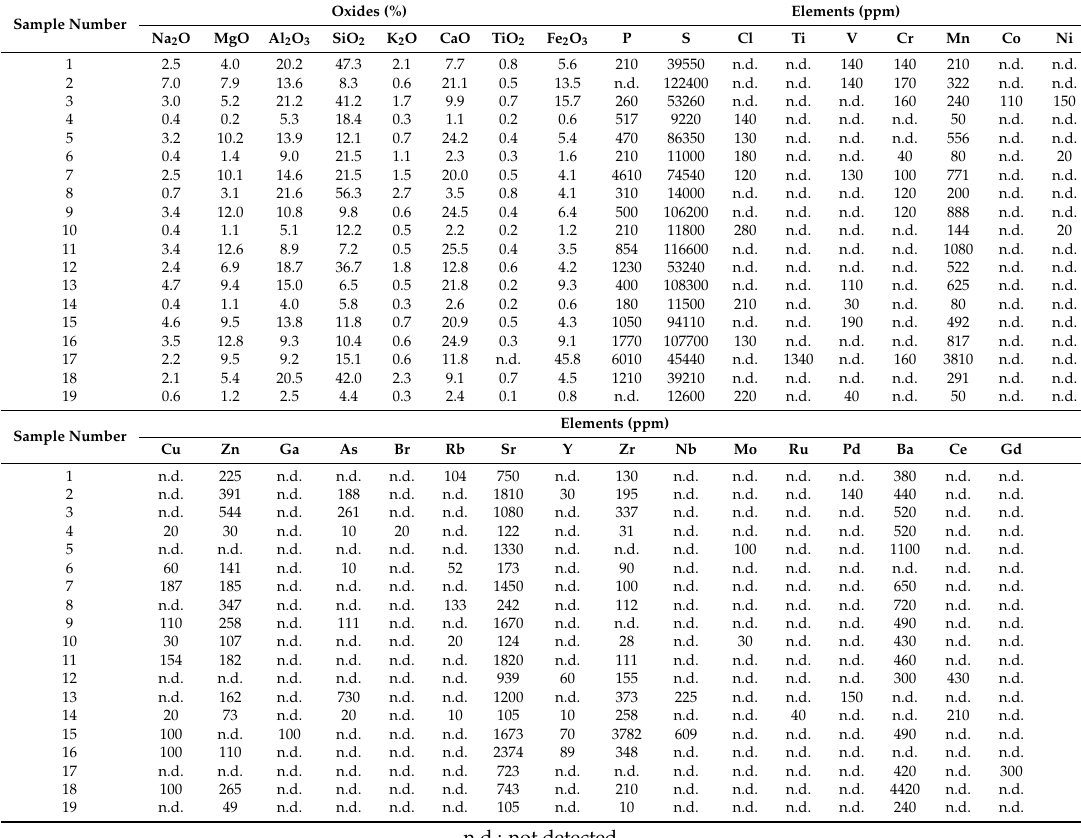
Table 2. Elemental concentrations in coal samples from the Shengli coal deposits.